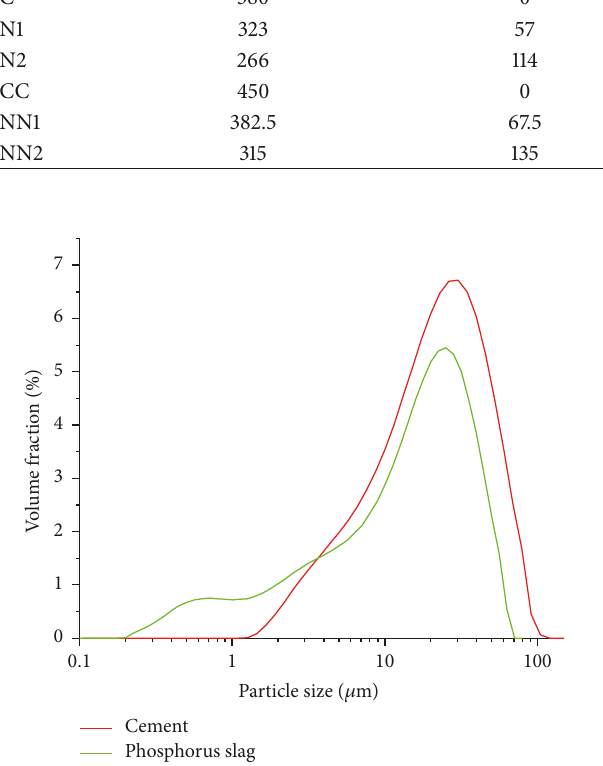
Figure 3: Particle size distributions of the cement and the phospho- rus slag.